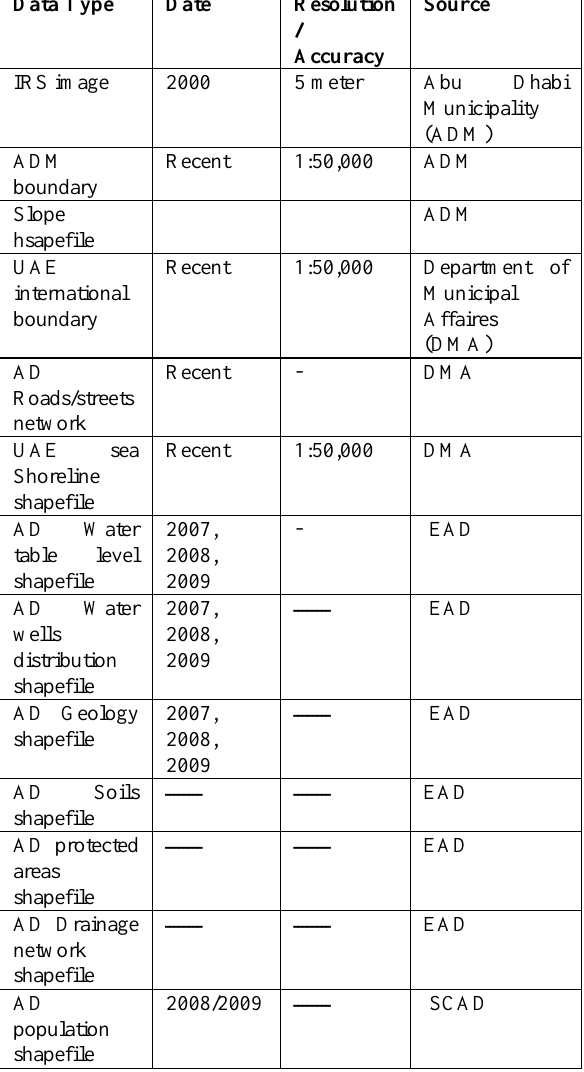
Table 2. Summary of data and data sources used in the